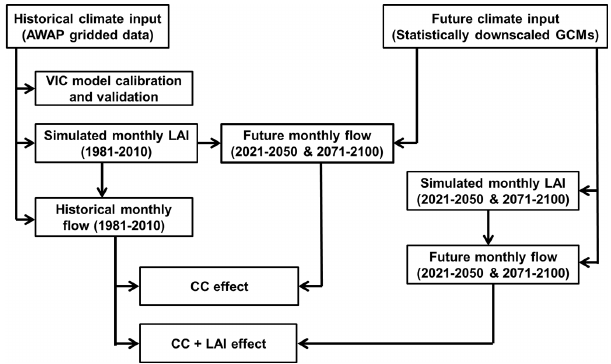
Figure 3. Flowchart showing the modeling experiments and calcu- lation of effects: CC effect indicates the climate change effect of precipitation and temperature with unchanged LAI, CC + LAI ef- fect indicates the climate change effect of precipitation, temperature and leaf area